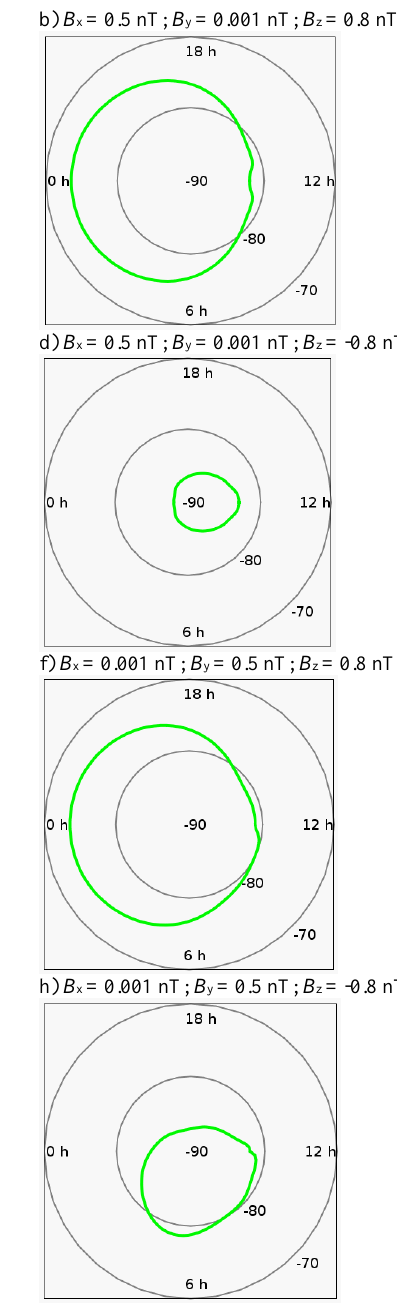
reduced again due to the smaller value of B z . For k s = 0.2 the open field area is reduced throughout compared with k s = 0.8, while the effect of IMF B y is more pronounced, the open